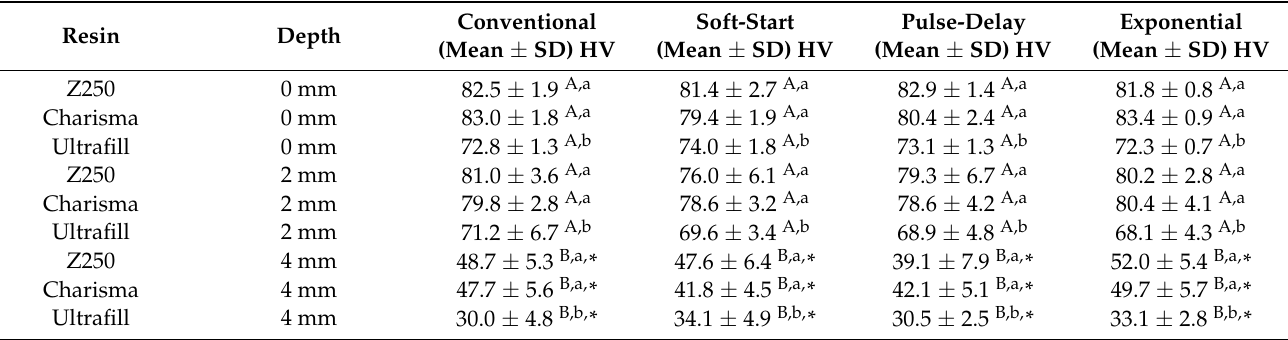
Table 5. Mean and standard deviation of resin hardness as a function of the depth. Different letters indicate statistically significant differences ( p < 0.05). Uppercase letters compare the effect of each photoactivation protocol on the hardness (within lines), and lowercase letters compare the effect of the resin composite on the hardness (within columns). * indicate relative hardness statistically <80% of the hardness at 0